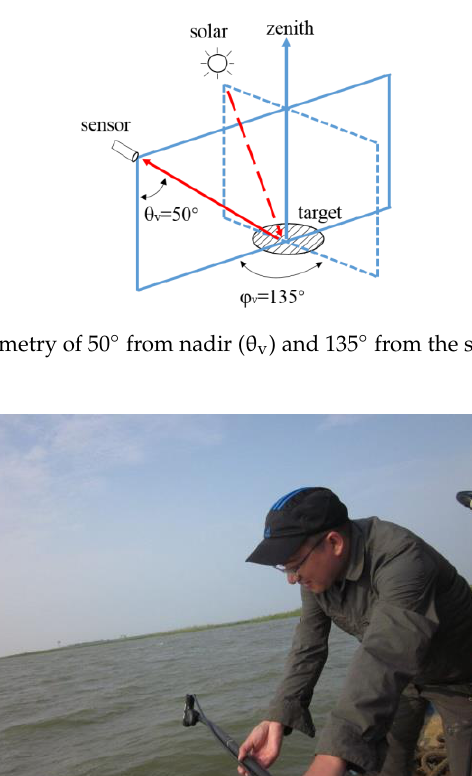
Figure 2. The uncertainties in viewing geometry with manual operation.